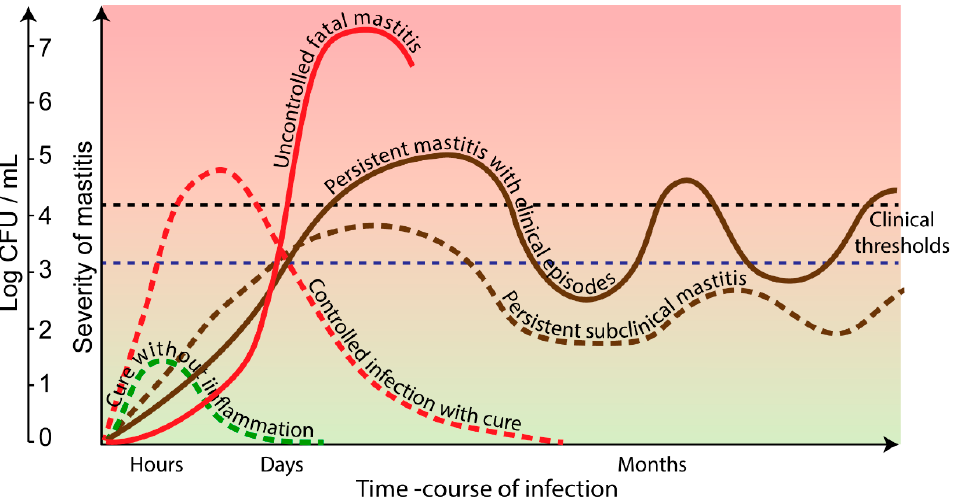
Figure 1. Different types of mastitis vaccination possible outcomes. The figure describes the time course of disease (bacterial cfu in milk) in unvaccinated (solid lines) and vaccinated (dotted lines) cows. In unvaccinated cows, mastitis may get out of control, usually after a sluggish immune response (red solid line), and the udder quarter is treated with an antimicrobial. In most cases, after a clinical episode, the infection persists in a subclinical state interspersed with short clinical episodes (brown solid line). In vaccinated cows, three schematic outcomes may occur. In the best but unfortunately unachieved case, the vaccine prevents infection (green dotted line). The coveted goal is to achieve sterilizing immunity, often after a short period of clinical mastitis (red dotted line). In most cases, the vaccine limits the severity of mastitis, maintaining the infection below the threshold of detection in a subclinical but persistent situation (brown dotted line). These outcomes are grossly linked to the concentrations of bacteria shed in milk, although variations occur as a function of the pathogen and the cow’s resistance or resilience. The clinical threshold is defined by the visible local and systemic symptoms, the lower threshold is by the milk appearance.